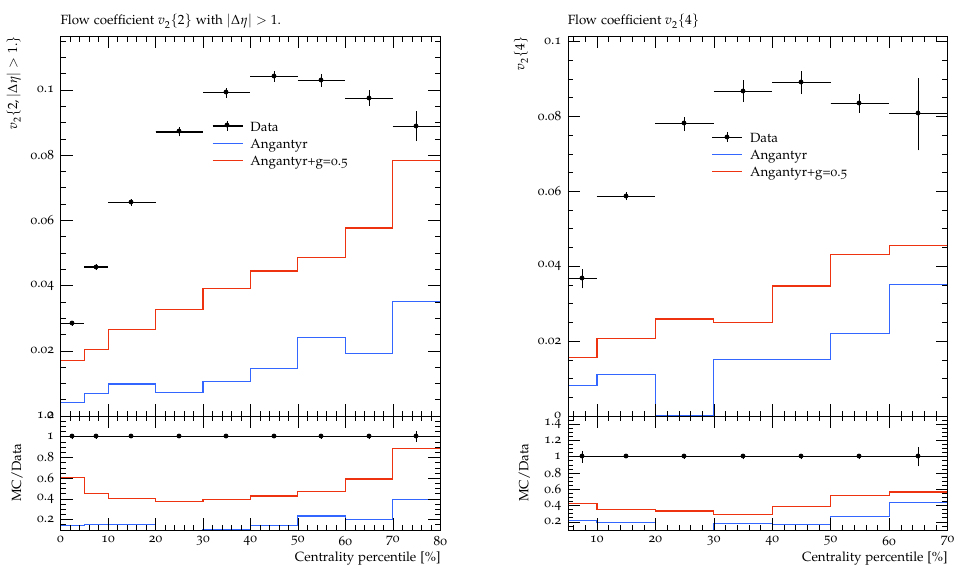
Figure 17 . The flow coefficient v 2 { 2 } (left) with | ∆ η | > 1 and v 2 { 4 } (right) for 0 . 2 < p ⊥ < 5 . 0 GeV √ in Pb-Pb collisions at s NN = 5 . 02 TeV [86]. integrated over the p range 0 . 2 < p < 5 . 0 GeV for 5.02 TeV Pb-Pb collisions [86] ⊥ ⊥